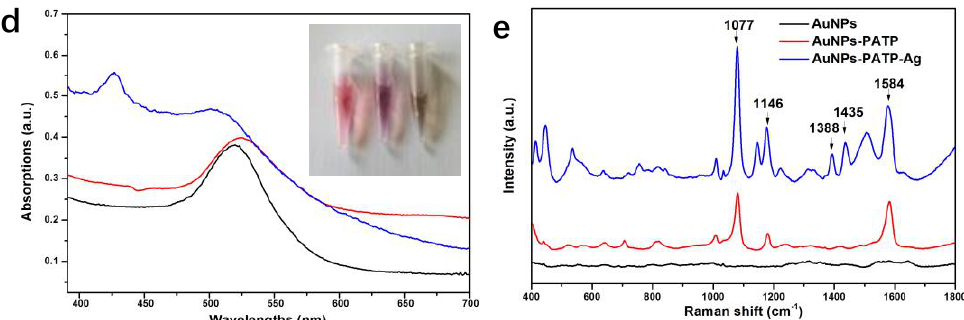
Figure 2. ( a–c ) TEM images of core-shell nanoparticles (NPs) modified with 5 × 10 –4 M 4-PATP; ( d ) UV-vis absorption spectra of Au NPs, Au-PATP NPs, and Au-PATP-Ag NPs colloids, the inset is the photograph of Au NPs, Au-PATP NPs, and Au-PATP-Ag NPs colloids (from left to right); ( e ) surface-enhanced Raman scattering (SERS) spectra of the metal NPs.